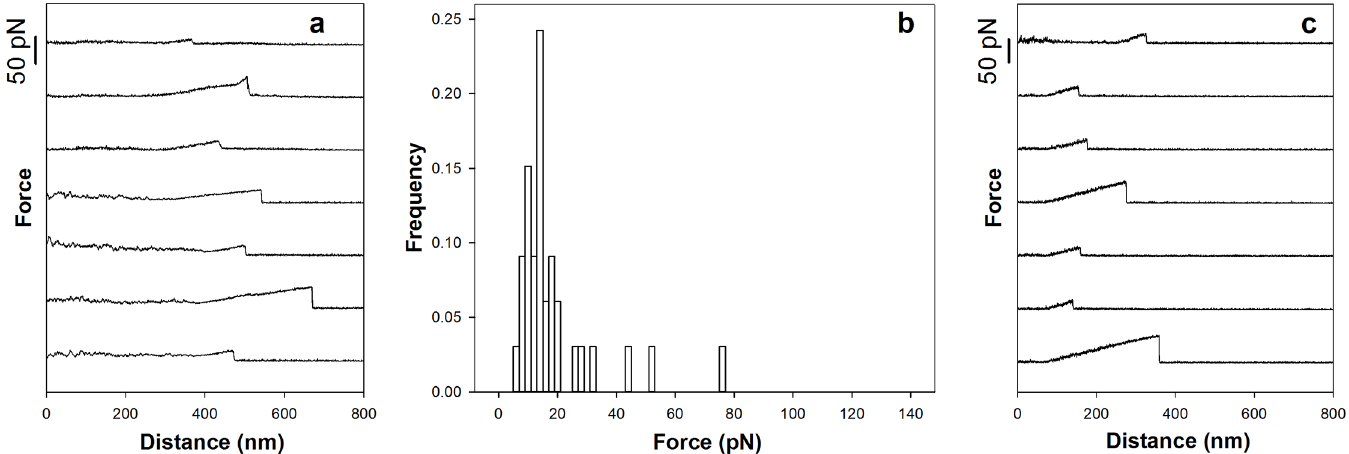
Fig 6. Optical tweezer characterization of the MUC1(Tn)–MGL interaction in buffer containing Ca 2+ chelator. (a) Force versus distancecurves obtained after addingEDTA to the Ca 2+ containing Hepes buffer that filled up the sample chamberof the OT instrument. (b) Distributions of intermolecular rupture events betweenMUC1 mucins and MGL determinedunder the experimental conditions describedin (a). The histogramdistributionis based on 33 observedrupture events. (c) Force versus distancecurves obtainedwhen investigating the interactionbetweenMUC1(Tn) and MGL in a sample chamber filled with a Hepes buffer not containingCa 2+ ions.